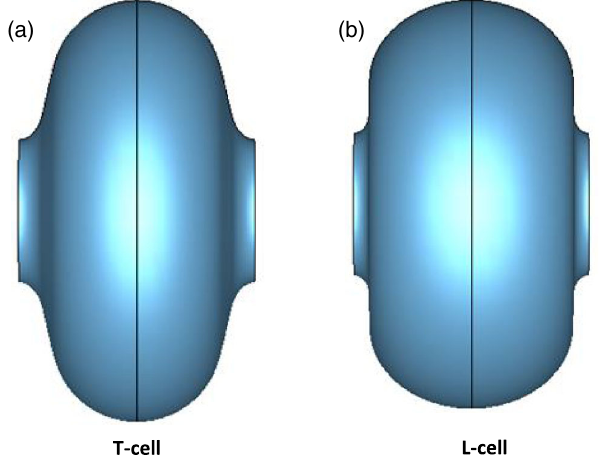
FIG. 2. 3D drawings of (a) the elliptical or Tesla-type (T) cell and (b) the low loss (L) cell.